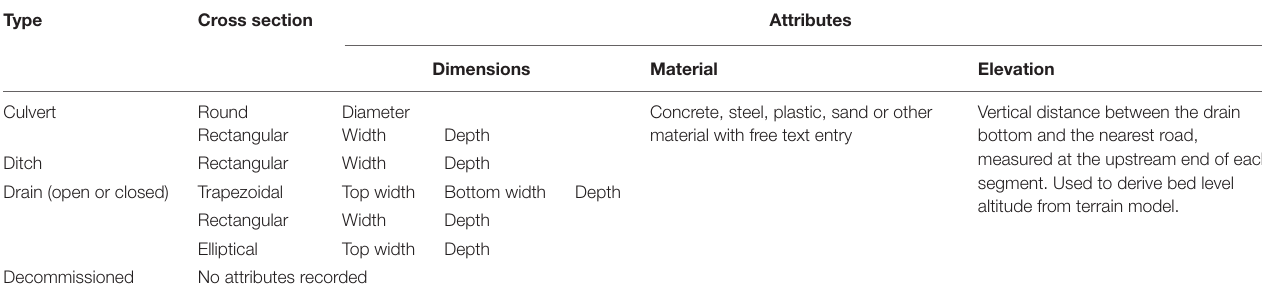
TABLE 1 | Collected drainage data.